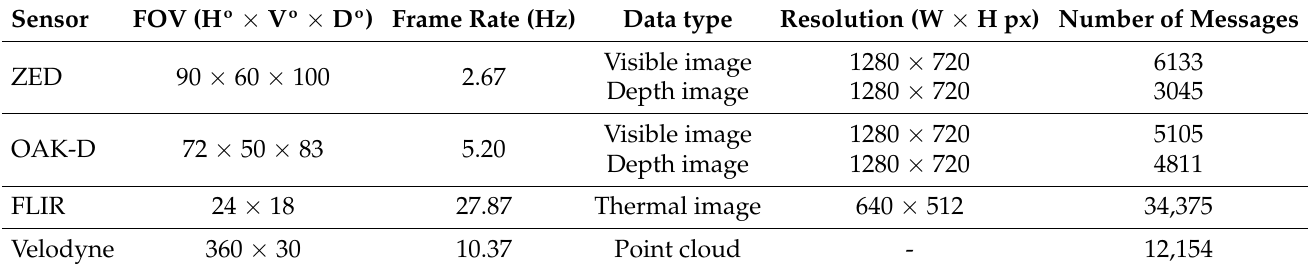
Table 5. Partial description of the dataset acquired by the sensors mounted on AgRob V16: FOV, data types, data resolution, frame rate, and total number of messages related to each